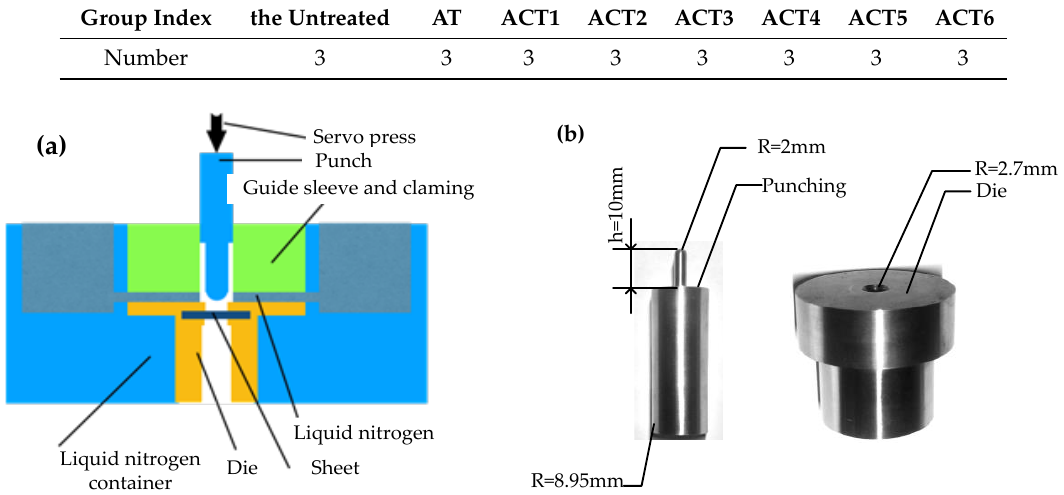
Table 4. Test samples for deep drawing tests.